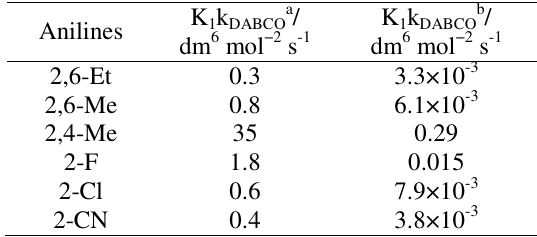
Table 3. Compared the results of reactions of 1,3,5-trinitrobenzene and 2-phenoxy-3,5- dinitropyridine with anilines in